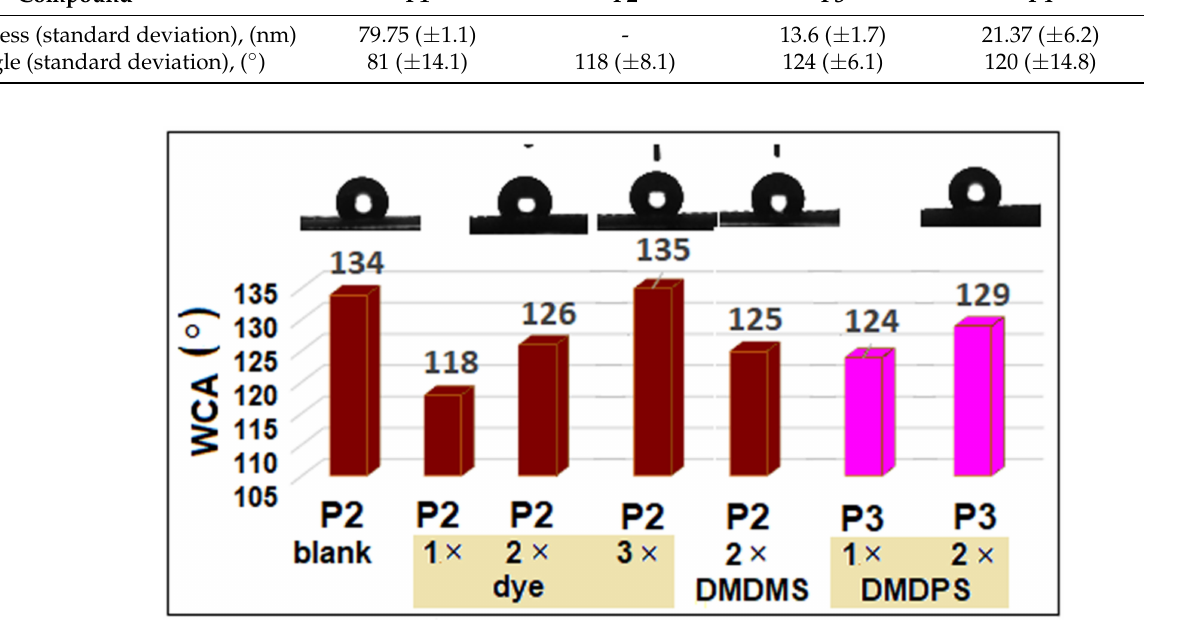
Figure 6. Modification of the hydrophobic properties of the coated polyester depending on the ratio between the components of the